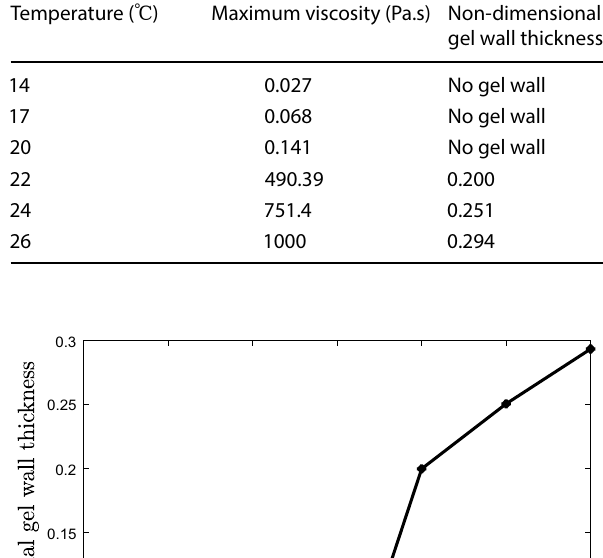
Table 4 Effect of temperature on viscosity and gel wall thickness Temperature ( ℃ )